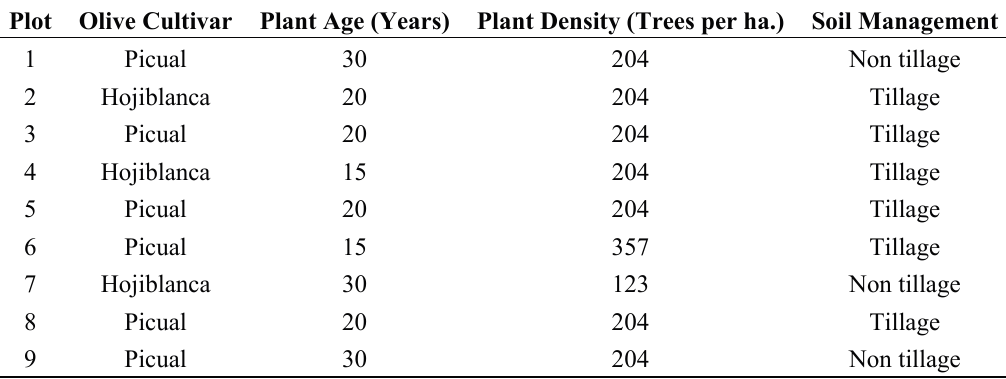
Table 1. Agronomic characteristics of olive plots assessed in this